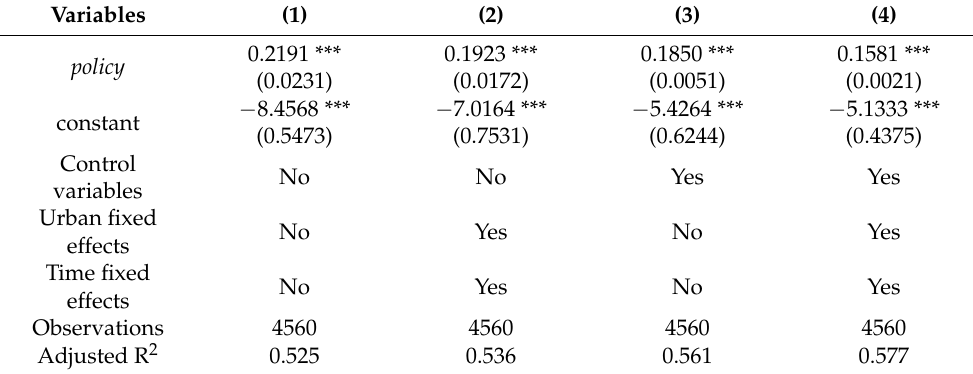
Table 6. Regression results of PSM-DID